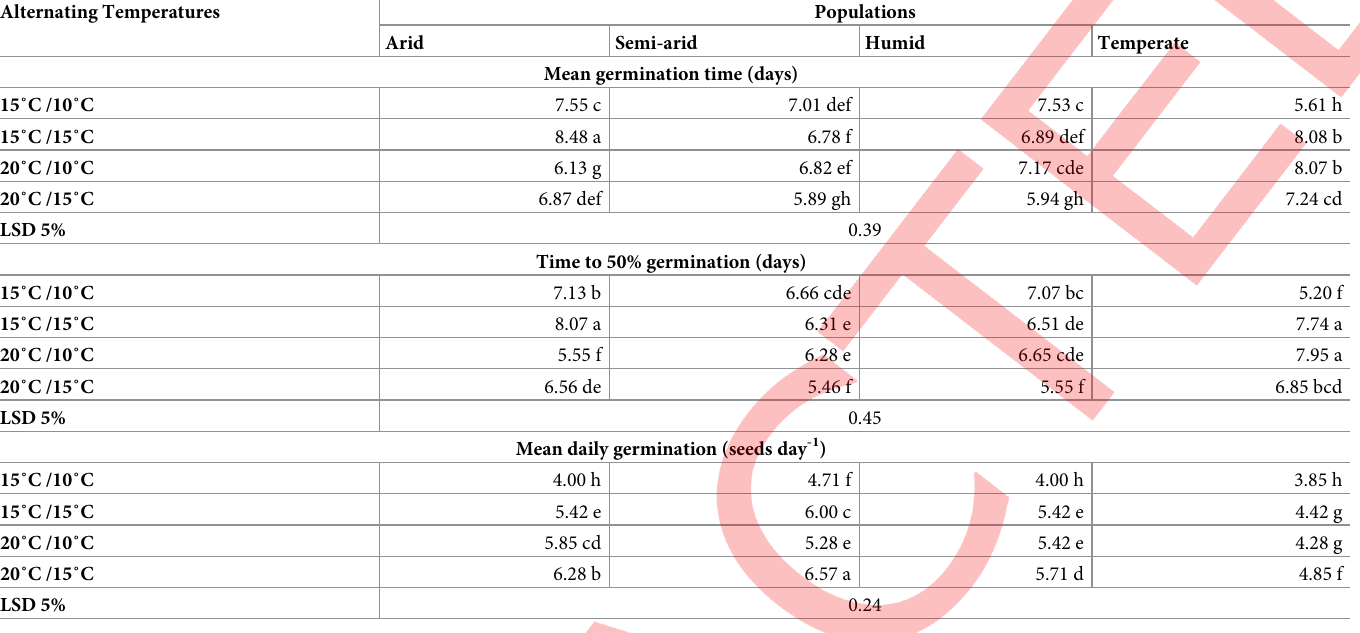
Means followed by same letters within a column or row are statistically similar (p > 0.05) for the respective germination indices.